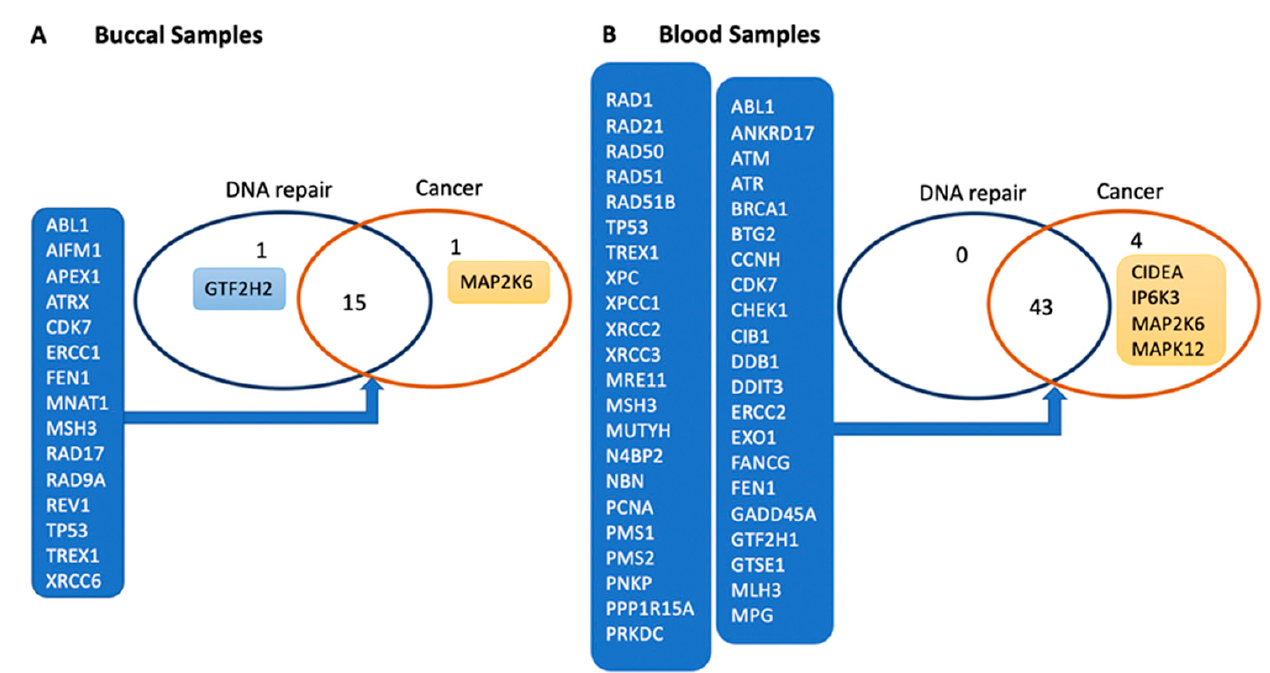
Figure 3. Venn diagram of genes involved in DNA repair and cancer in buccal and/or blood samples. ( A ) Fifteen genes that are differentially expressed in buccal epithelium and 43 genes that are differentially expressed in blood are involved in DNA repair and cancer ( B ). Mitogen-activated protein 2 kinase-6 ( MAP2K6 ) cancer gene is differentially expressed in buccal epithelium and blood samples ( A , B ). Four cancer genes, including MAP2K6, were differentially (but not significantly) expressed in blood samples ( B ).